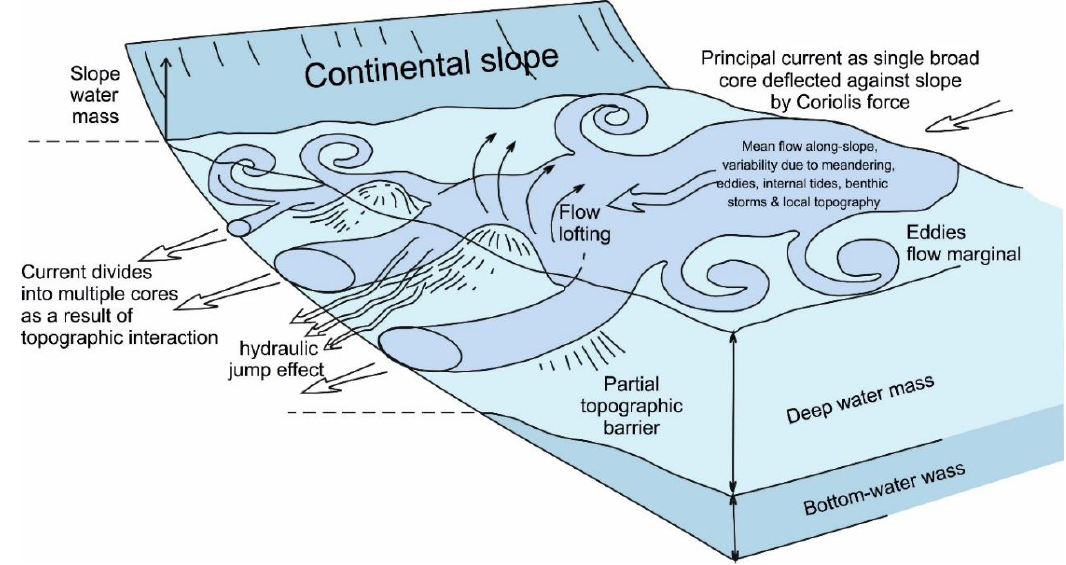
Figure 4. Schematic view (3D) of a bottom (contour) current, identifying the current core, eddies and strands within a deep-water mass. Typical physical parameters as shown. Modified from [63].